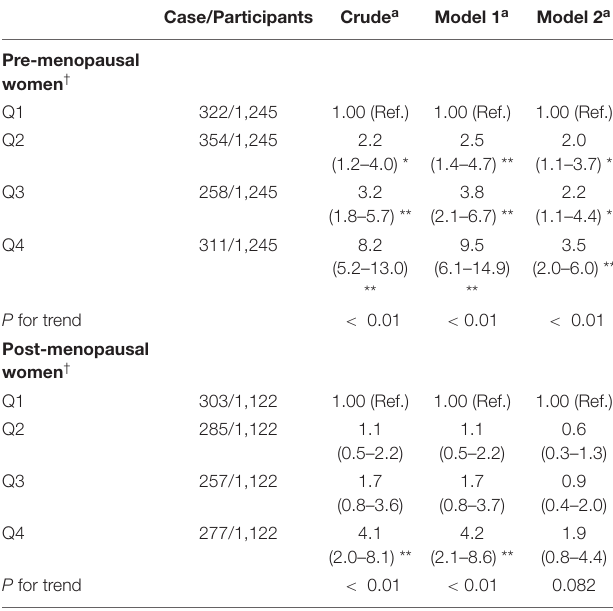
TABLE 8 | Weighted odds ratios (95% confidence intervals) for insulin resistance (HOMA-IR) of participants across quartiles of serum uric acid, stratified analysis